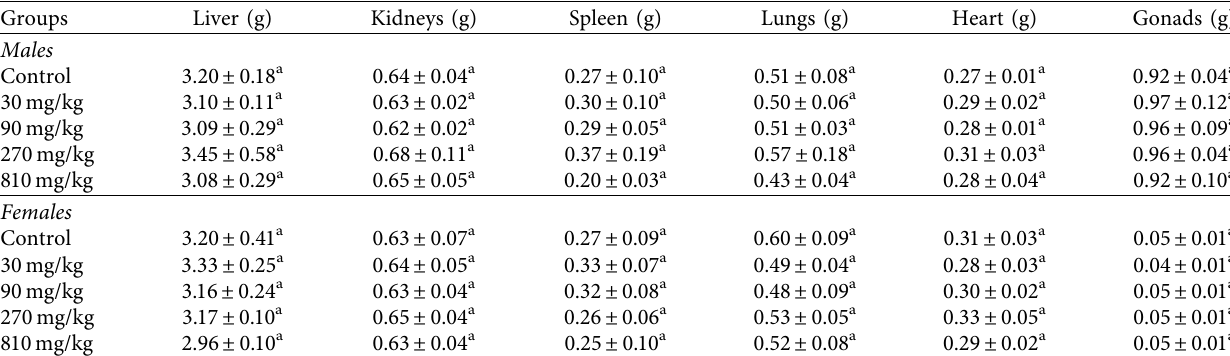
Table 3: Effect of aqueous extract of T. grandis leaves on relative organ weights of animals.